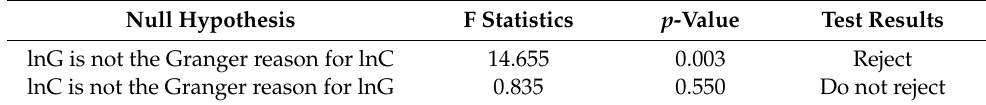
Table 5. Granger causality test results.